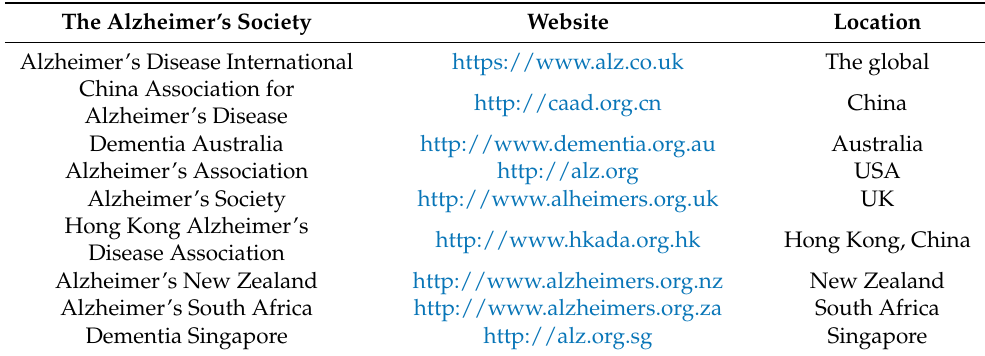
Table 1. Overview of the Alzheimer’s Society ( n = 9). The Alzheimer’s Society Website Location Alzheimer’s Disease International https://www.alz.co.uk The